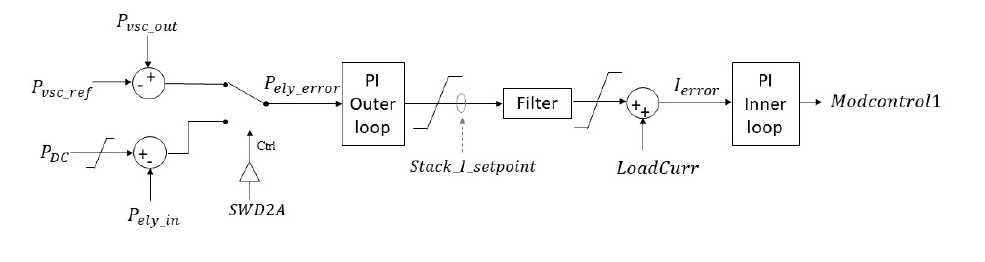
Figure 12. Buck converter controller in Scenario 1. SWD2A is the fault signal and Modcontrol1 is the fire pulse signal.